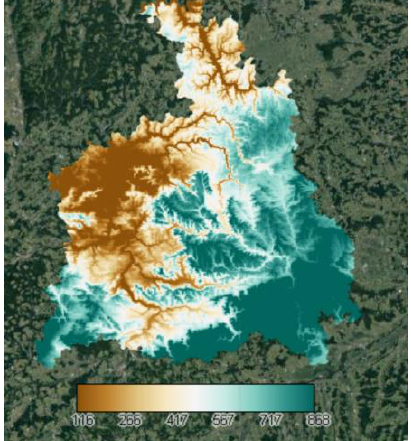
Figure 11: Wind raster